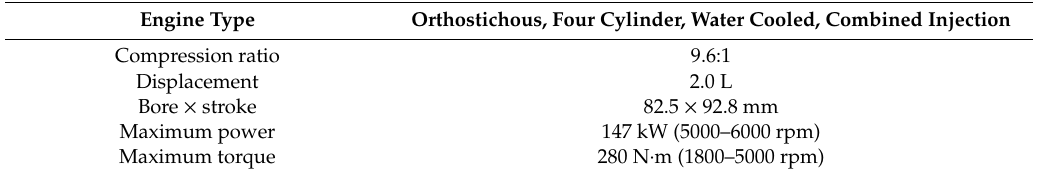
Table 1. Main technical parameters of the commercial engine.